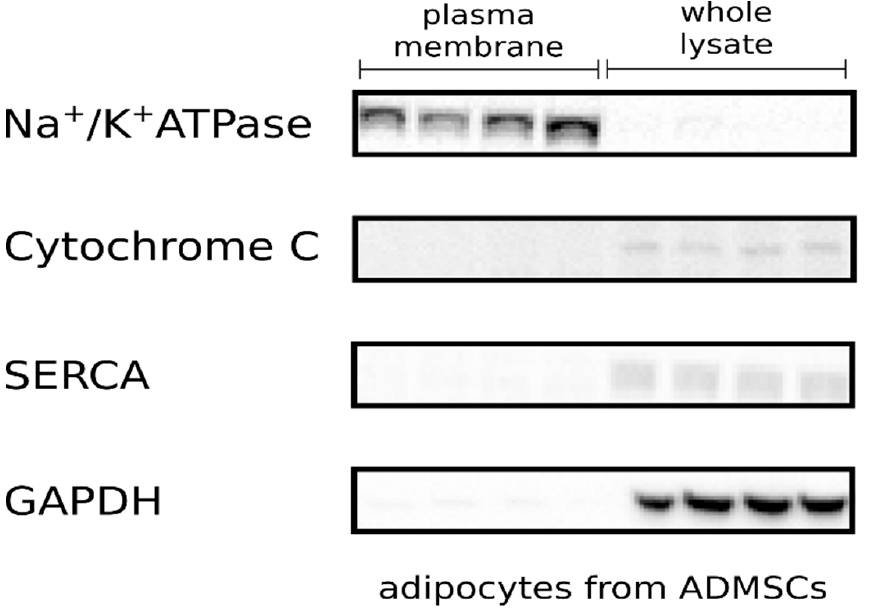
Figure 1. Representative Western blots showing the distribution of the Na + /K + ATPase, SERCA, cytochrome C and GAPDH in the plasma membrane and whole lysate.